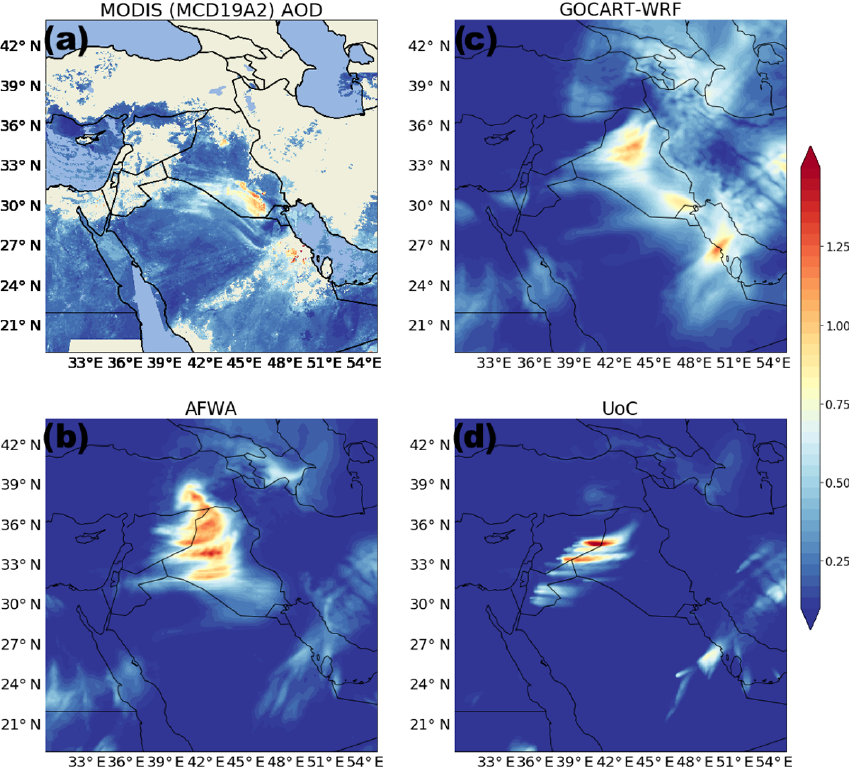
Figure 8. The (a) MCD19A2 MODIS AOD product for 25 January 2010 and simulated 8h average 550nm AOD centered at 10:00UTC on 25 January 2010 for (b) AFWA, (c) GOCART-WRF, and (d) UoC.